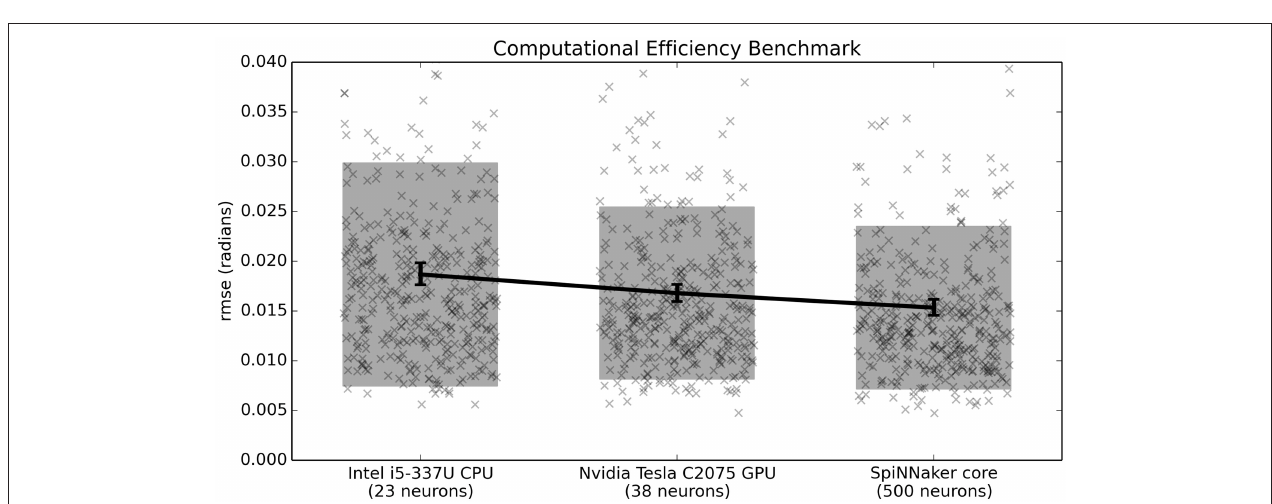
FIGURE 7 | Benchmark results comparing three hardware systems in terms of their performance when running as many neurons as they are capable of per 0.1 Watt of power consumption. Scatterplots show individual runs (with random jitter on the x-axis to avoid overlap), the shaded area is the mean plus or minus the standard deviation, and the 95% confidence interval of the mean is shown. All differences are statistically significant ( p < 0.05 ; two-tailed t -test with Bonferroni correction; 400 samples per